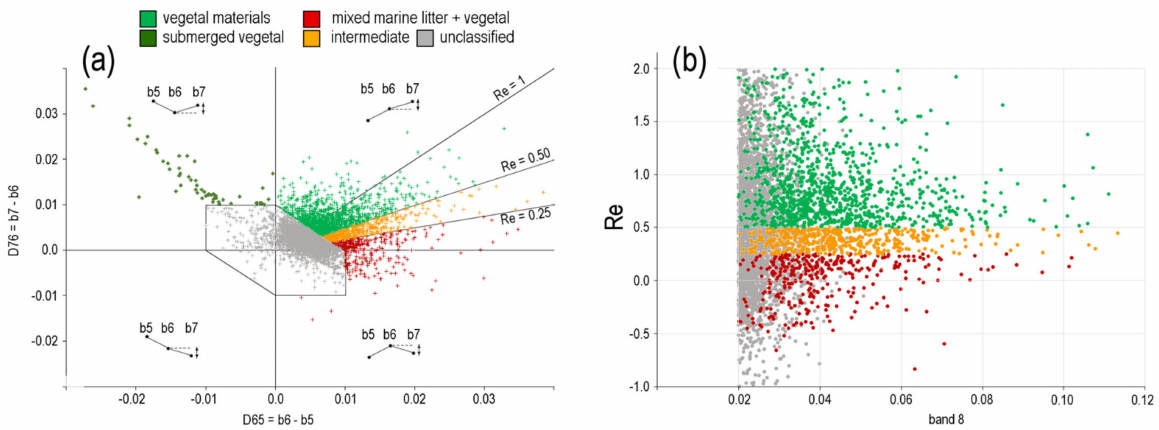
Figure 4. ( a ) Classification method based on spectral differences D 65 = b 6 − b 5 ( x -axis) and D 76 = b 7 − b 6 ( y -axis); Re = D 76/ D 65; the grey polygon fits the condition: range ( b 5, b 6, b 7 ) ≤ 0.01. ( b ) Classified pixels plotted vs. band 8 (NIR).